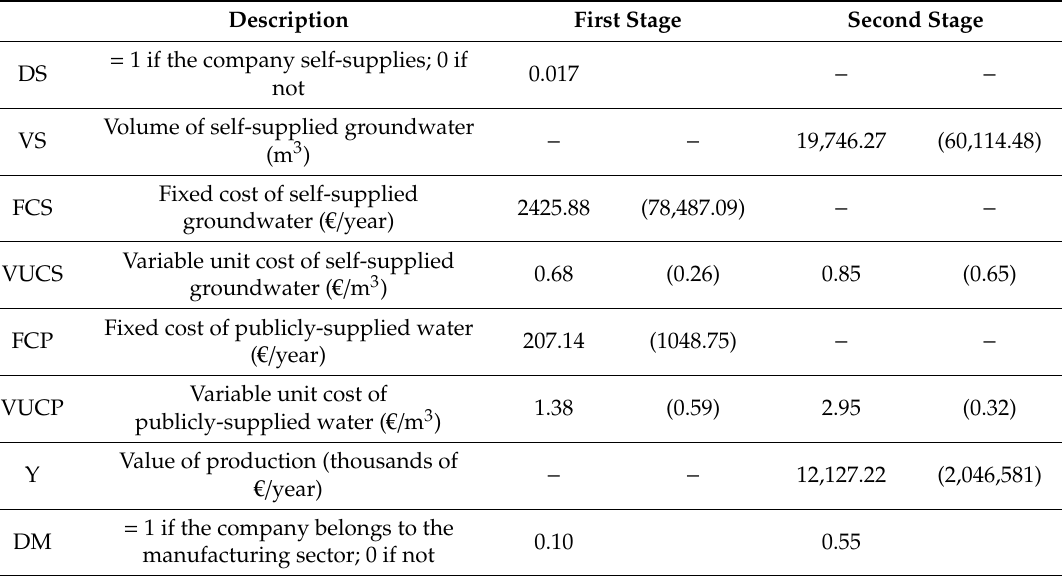
Table 2. Average values of the variables for the case study (2012).